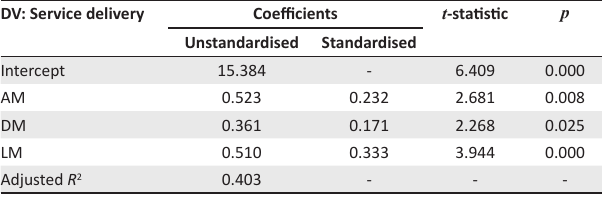
TABLE 5: Regressing service delivery on acquisition management, demand management and logistics management. DV: Service